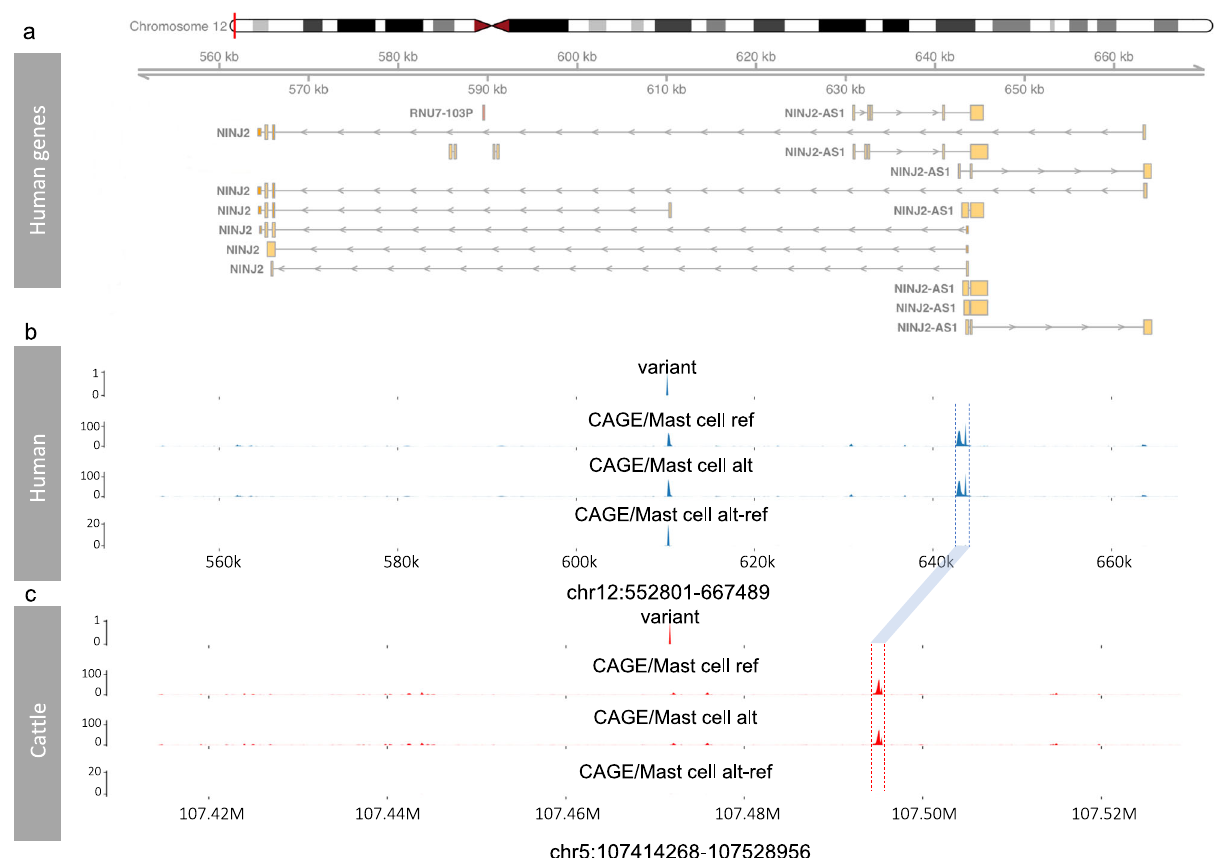
Fig. 8 Enformer predictions for human and cattle. a The human gene neighborhood of variant rs10849334. Different isoforms of the genes are included in the plot. b Enformer predicted Cap Analysis Gene Expression (CAGE) tracks of variant rs10849334 in mast cells (the track showing the largest human alt- ref difference). The fi rst three tracks show i) the position of the target variant in the human genome, and the predicted CAGE levels for the ii) reference and iii) alternative alleles from Enformer, i.e., the predicted CAGE tracks obtained by taking the human DNA sequences containing reference and alternative alleles at the variant position as the inputs of the Enformer model. The fi nal track shows the predicted difference between the CAGE levels from the reference and alternate sequences (alt-ref). As can be seen the only difference is observed speci fi cally at the start position of the shorter NINJ2 isoform in the centre of the plot. c Corresponding predicted CAGE tracks derived from the cattle sequences around the orthologous variant of rs10849334. The orthologous peaks at the TSSs of the longer NINJ2 transcripts in cattle and human are indicated by the blue linking bar. However, no CAGE peak is predicted at the TSS of the shorter isoform of NINJ2 , unlike with the human sequences. The data underlying this fi gure can be found in Supplementary Data